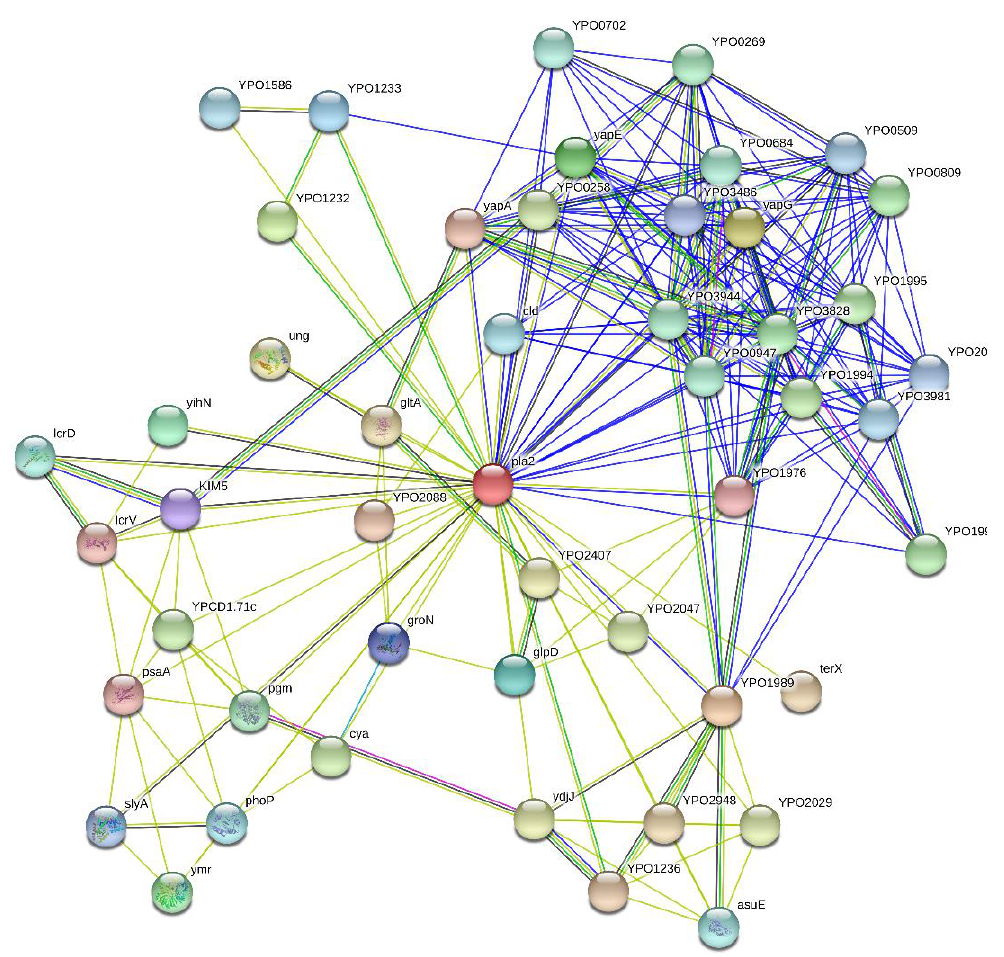
Figure 4. Interactability of Pla with other Y. pestis proteins. The Pla-centered protein-protein interaction (PPI) network was generated by the Search Tool for the Retrieval of Interacting Genes; STRING (http://string-db.org/. STRING). This later generates a network of associations based on predicted and experimentally-validated information on the interaction partners of a protein of interest [108] . In the corresponding network, the nodes correspond to proteins, whereas the edges show predicted or known functional associations. Seven types of evidence are used to build the corresponding network, where they are indicated by the different colored lines: a green line represents neighborhood evidence; a red line—the presence of fusion evidence; a purple line—experimental evidence; a blue line—co-occurrence evidence; a light blue line—database evidence; a yellow line—text mining evidence; a black line—co-expression evidence [108] .